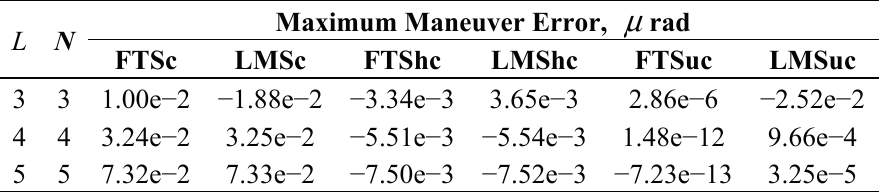
Table 17. Maximum maneuver error over 2 s